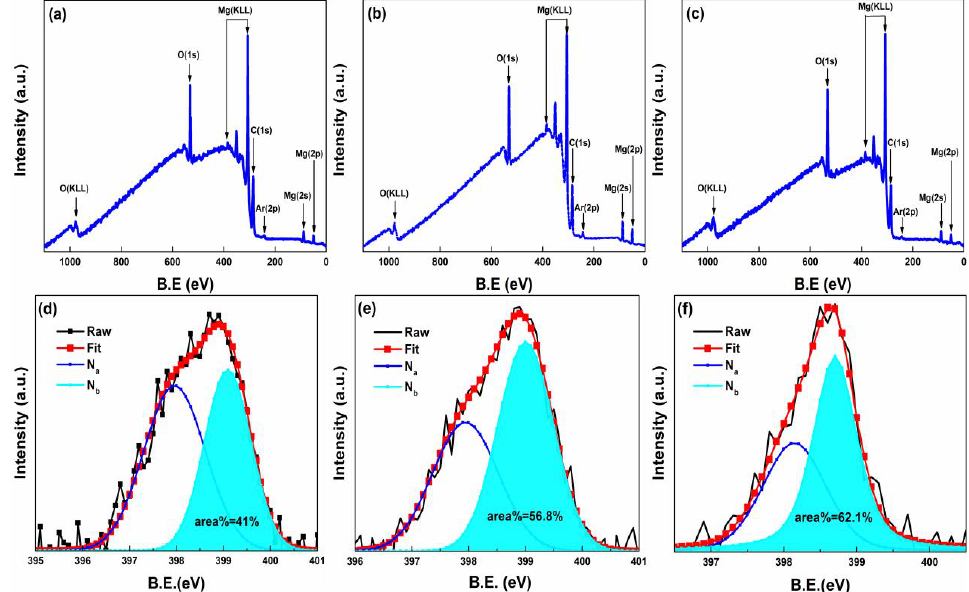
Figure 2. Total XPS spectrum of the pristine samples with the ( a ) (110) orientation, ( b ) (100) orientation, and ( c ) (111) orientation. N 1s XPS signals of as-implanted samples with ( d ) (110), ( e ) (100), and ( f ) (111) orientation.